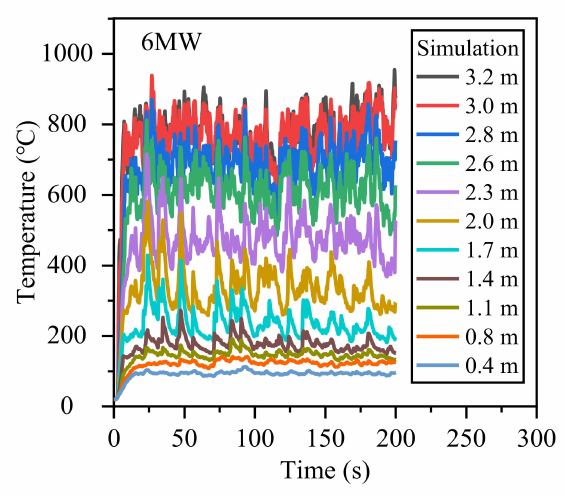
Figure 28. Window edge temperature under window sprinkler conditions.